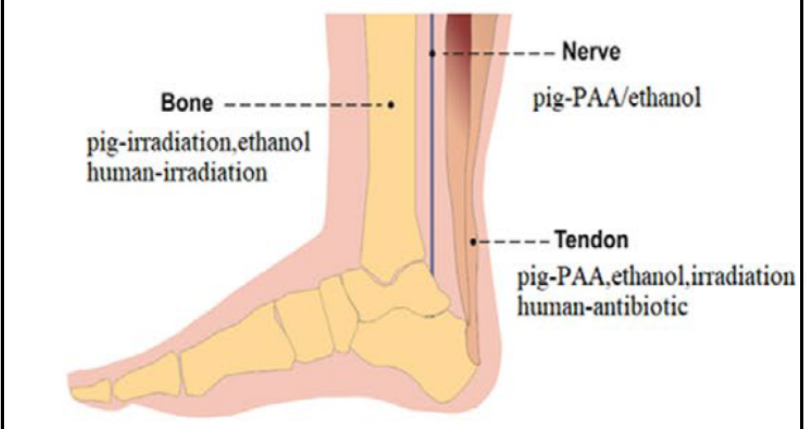
Figure 8. Recommended sterilization methods of bone, nerve, and tendon pig-derived dECMs. Adapted from [54].